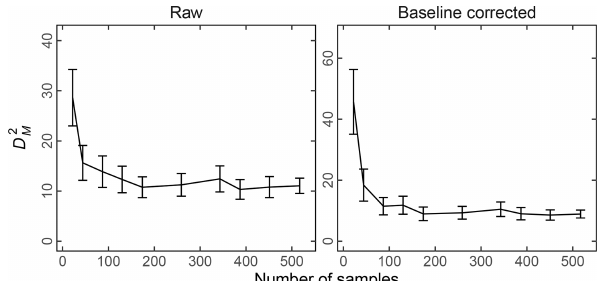
Figure 16. Mean squared Mahalanobis distance ( D 2 spectra of the fixed test set and changing calibration set, constructed as described in the caption of Fig. 9. Error bars span ± 1 standard deviation. The first 10 latent variables are used for estimation of D 2 in this example to reduce the dimensionality of the factor space M (Brereton and Lloyd,